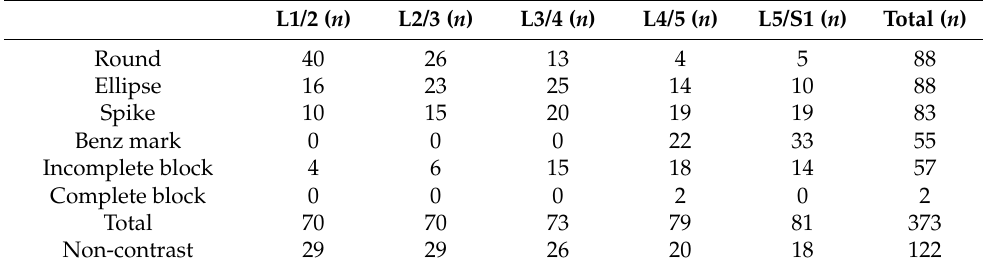
Table 4. Computed tomography epidurography.